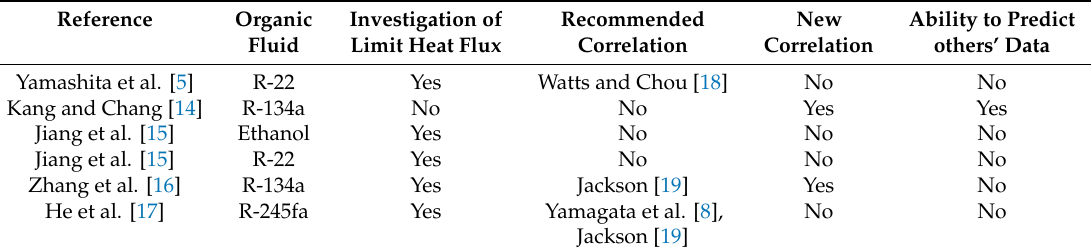
Table 1. Investigations for performance of the heat transfer coe ffi cient (HTC) and heat